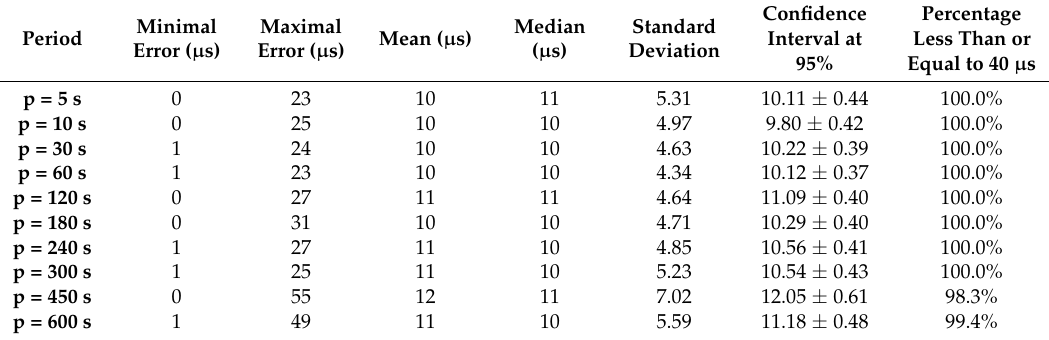
Table 1. Results obtained in the precision experiment for GTSO (HSE as RTC